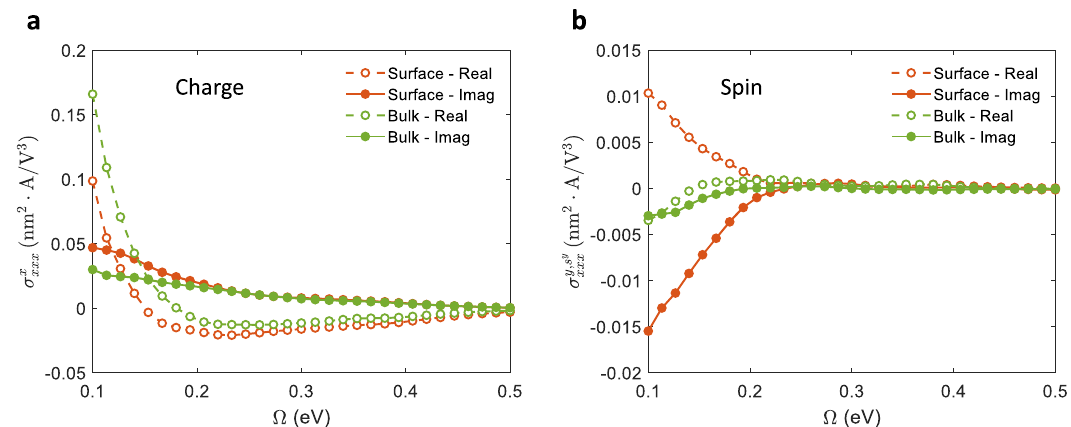
Fig. 5 Third-order conductivity of T d -WTe 2. a Charge current and b spin current. Red and green curves are for surface and bulk responses, respectively. Solid and dashed curves are the imaginary and real parts of the response functions,